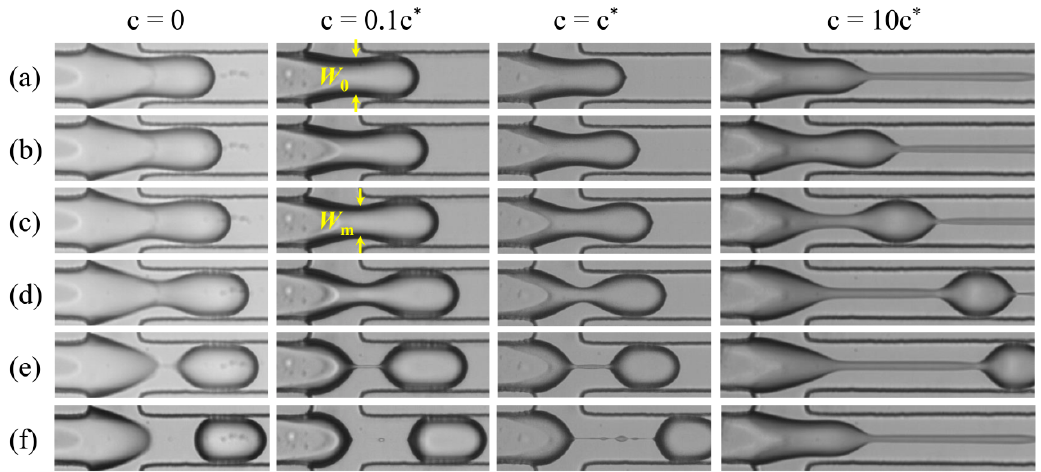
Figure 3. Sequences of images showing the thinning process of droplet generation for di ff erent solutions: ( a ) Initial regime; ( b ) t / t b = 0.2; ( c ) t / t b = 0.4; ( d ) t / t b = 0.8; ( e ) t / t b = 1; and ( f ) after breakup. Values of t b for the four cases are 14.8, 16.8, 18.4 and 60 ms, respectively. W 0 represents the initial thread width and W m represents the minimum thread width at a certain instant. For all cases, q = 4 and Q c = 40 µ L /